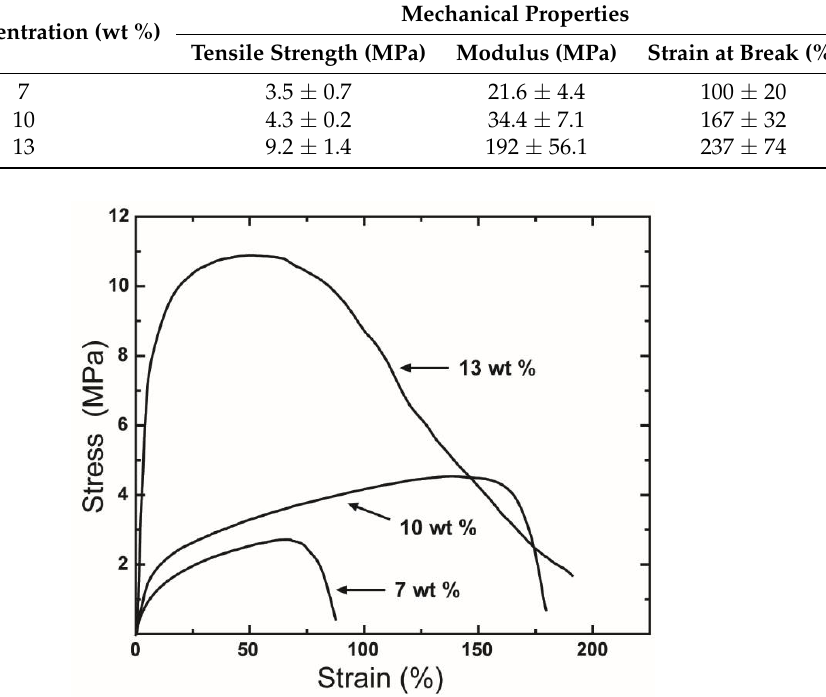
Figure 8. Tensile stress-strain curves of the fiber mats produced from polymer concentrations of 7, 10, and 13 wt %. Centrifugal spinning condition: rotational speed, 15,000 rpm; needle inner diameter, 160 μm; collection distance, 10 cm.